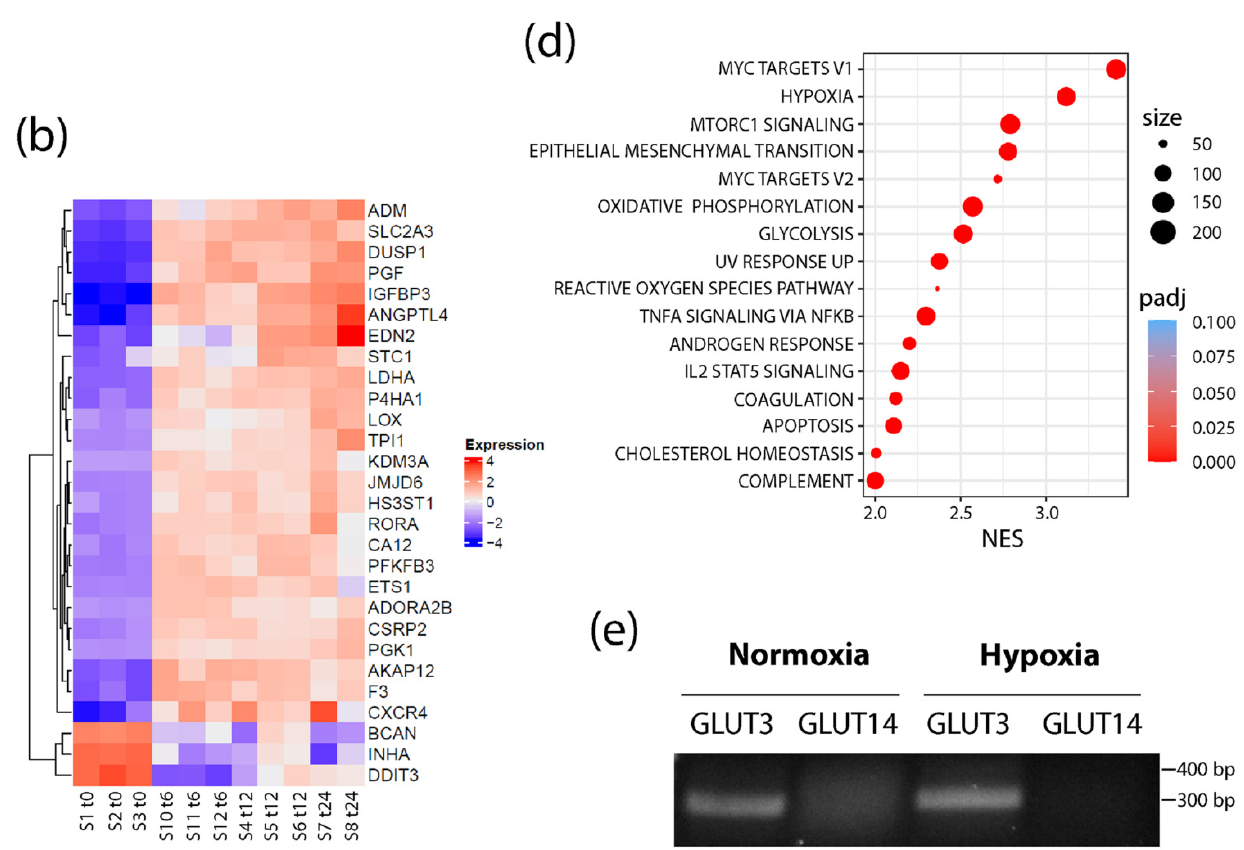
Figure 1. GLUT3/SLC2A3 is highly upregulated in hypoxic conditions. ( a ) Principal component analysis plot showing RNA-seq profiles of prostate cells samples (S) at 0, 6, 12, and 24 h after exposure to hypoxic conditions (1% O 2 ). ( b ) Heatmap represents the log2 (expression) values of all genes that are differentially expressed (Padj < 0.05 and abs [log2FC] > 2) in all three time points relative to the 0 h normoxia samples (S1–3), and that are also members of the MSigDB Hallmark hypoxia gene set. Each row has been mean-centered to better show changes in expression over time. ( c ) Volcano plot showing the average log2FC over each time point (6, 12, and 24 h) relative to 0 h normoxia samples ( x -axis), and average significance (computed as − log10Padj) over each time point relative to 0 h normoxia samples ( y -axis). ( d ) Dot plot shows all upregulated MSigDB Hallmark gene sets with Padj < 0.05 and normalized enrichment score (NES) > 2 when performing gene set enrichment analysis on the average rank times the sign of the fold change across each of the three time points (6, 12, and 24 h) relative to 0 h normoxia samples. The size of the dot indicates the total number of genes annotated to the Hallmark gene set. Color of the dot indicates the Padj value. ( e ) Primers specific for GLUT3 or GLUT14 were used for RT-PCR to assess expression in total RNAs isolated from normoxic and 24 h hypoxic RWPE1 cells. Predicted sizes of the PCR products: GLUT3, 299 bp; GLUT14, 370 bp. Note, this assay was used to simply detect the transcript and was not a quantitative assay of transcript